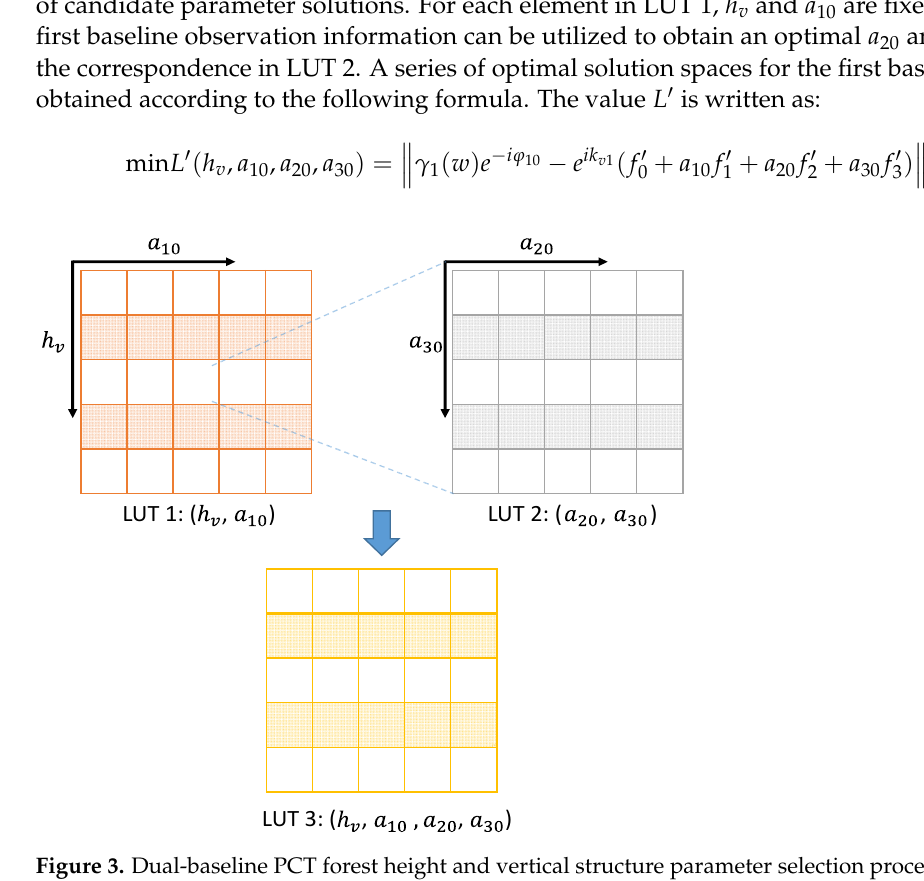
Figure 3. Dual-baseline PCT forest height and vertical structure parameter selection process.